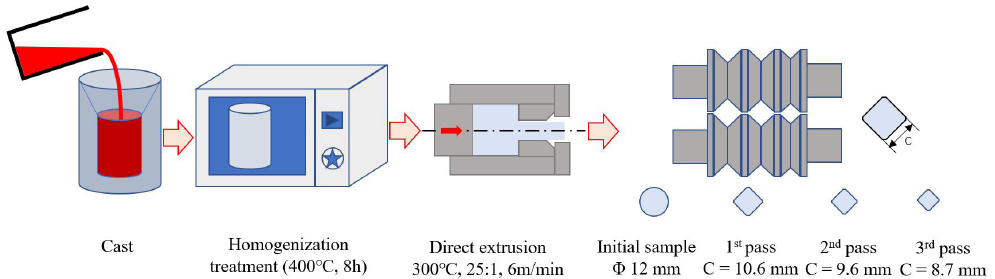
Figure 1. Schematic illustration of cast, homogenization, extrusion and caliber rolling process.